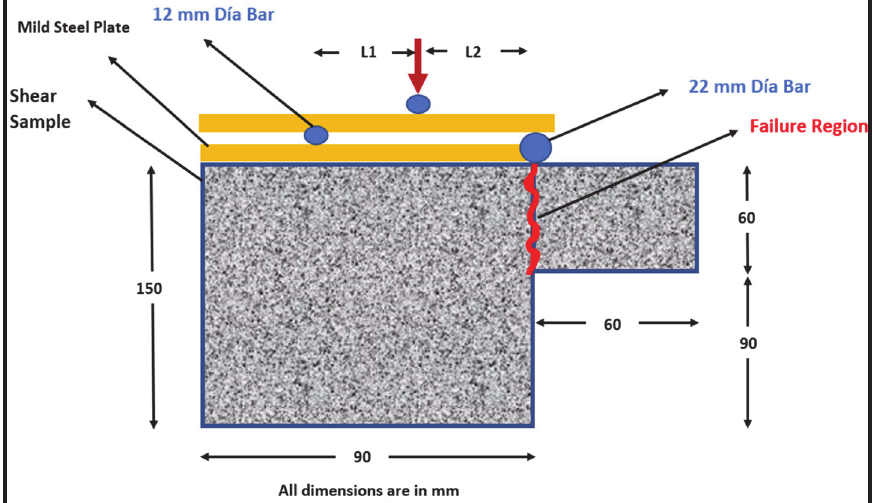
Figure 3: Schematic of shear test sample and its loading